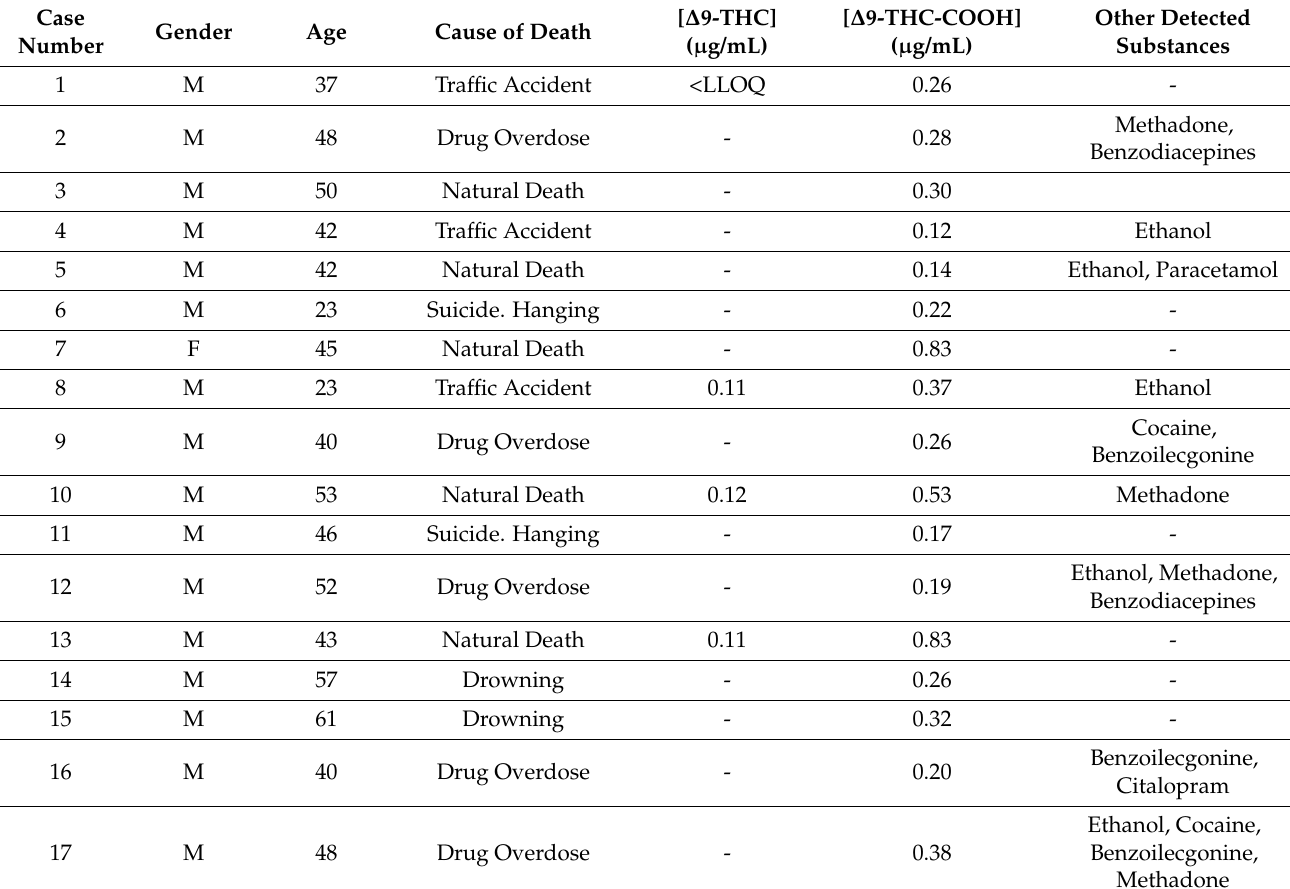
Table 4. Details of real cases testing positive for ∆ 9-THC and ∆ 9-THC-COOH.